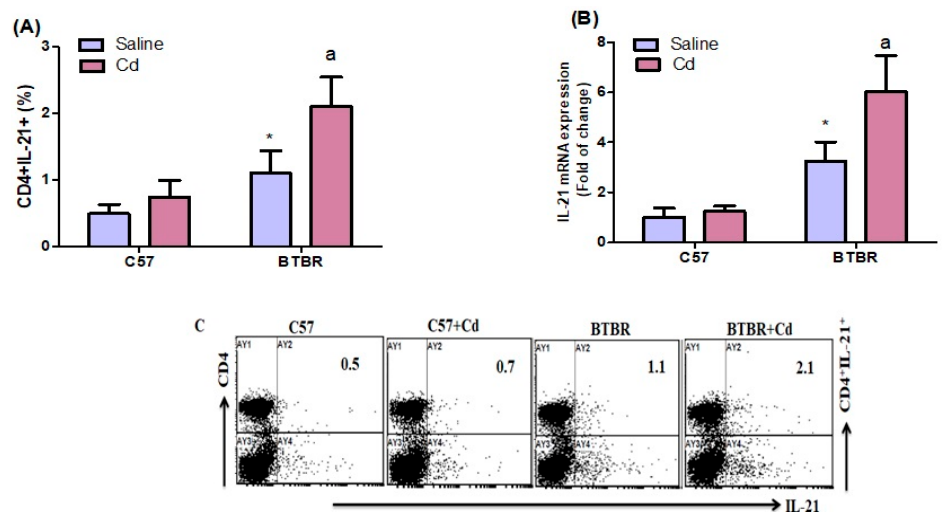
Figure 3. Effects of oral Cd exposure on IL-21. ( A ) IL-21-expressing CD4 + T cells from the spleen. ( B ) IL-21 mRNA expression in brain tissue. ( C ) Representative FSC-SSC dot plots of CD4 + IL-21 + cells taken from each mouse spleen. BTBR and C57 mice were exposed to Cd (5 mg/kg/day) or saline only (control) daily for six weeks. All data are shown as mean ± SD ( n = 6/group). Different letter indicate significant difference. * p < 0.05 vs. saline-treated C57 mice, ap < 0.05 vs. saline-treated BTBR mice; two-way ANOVA with Tukey’s test.